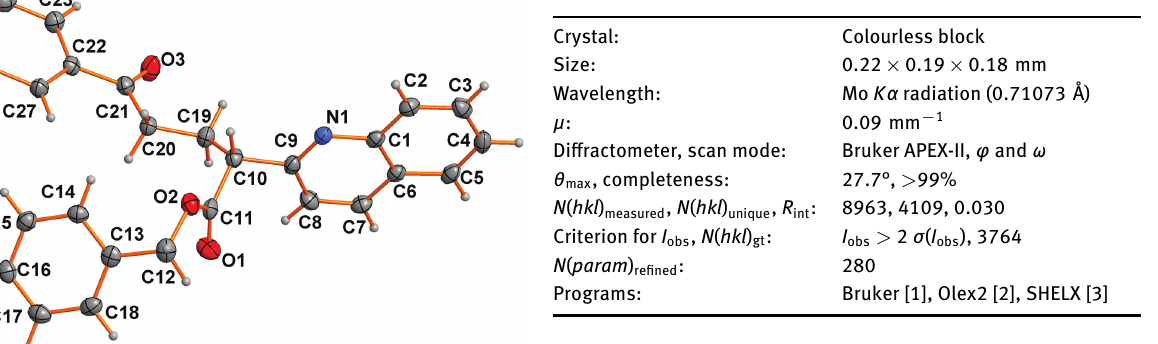
Table 1: Data collection and handling.